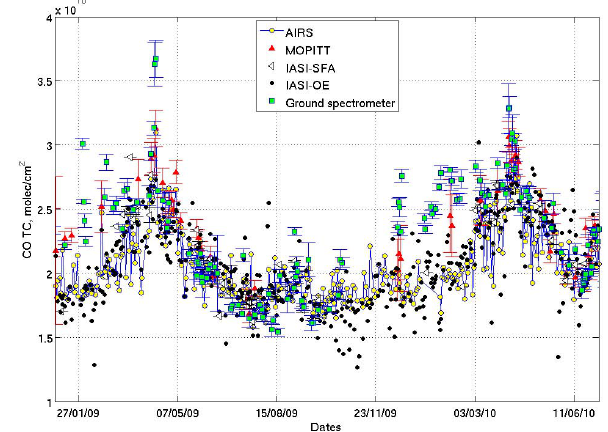
Fig. 2. Normalized averaging kernels for CO TC retrieved from data of space- and ground-based instruments, various days of 2010 (e.g. 0809 corresponds to 9 August 2010). A priori profiles: AP 5.4 corresponds to CO TC equal to 5.4 × 10 18 moleccm − 2 , etc. SCIA- MACHY AK is adopted from Liu et al. (2011).